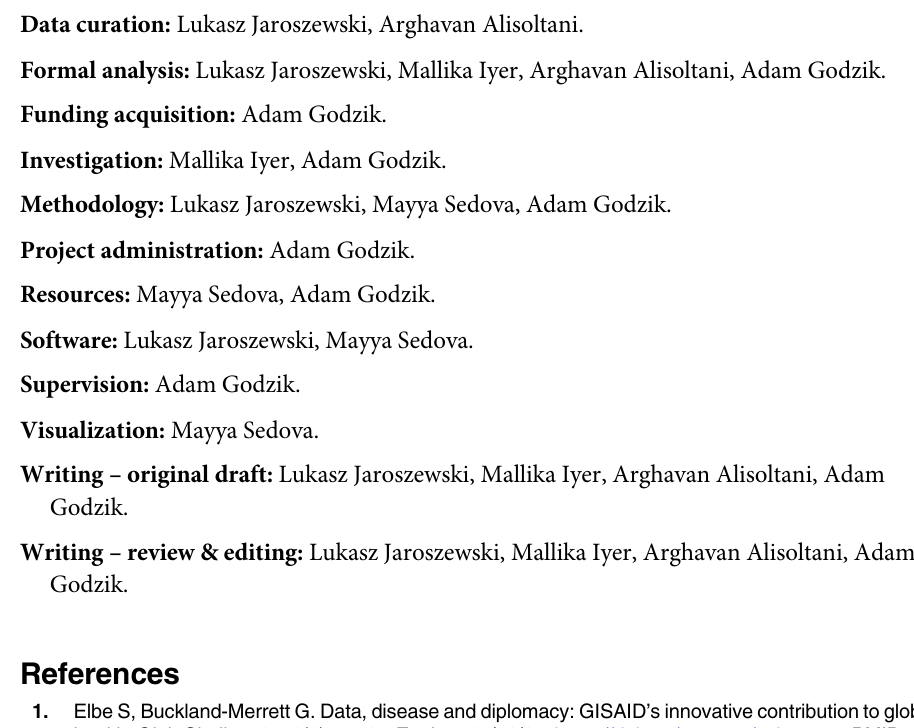
S2 Table. The list of domains analyzed using binomial tests for significant over- or under- mutation. S3 Table. The list of structures and models of biological assemblies used for structural cov- erage of SARS-CoV-2 proteome. S4 Table. The list of widely used PCR tests for diagnosis of SARS-CoV-2 along with muta- tion counts in their target regions and proteins coded by these